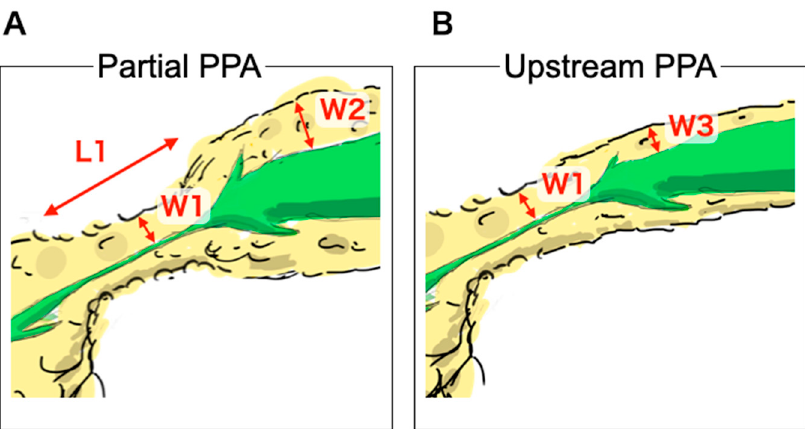
Figure 2. Definition of pancreatic parenchymal atrophy. ( A ); Partial pancreatic parenchymal atrophy (PPA) was defined when parameters obtained in CT met the following three criteria. First, a partial invagination of the pancreas parenchyma exhibited a width from the MPD wall of 4 mm or less (W1). Second, the length of the partial PPA ranged from 10 to 25 mm (L1). Third, the width of upstream side of parenchyma was more than 6 mm (W2). ( B ); Upstream PPA was defined as an overall upstream parenchymal atrophy with 4 mm or less in the width of stenosis site (W1) and upstream side (W3) of parenchyma.